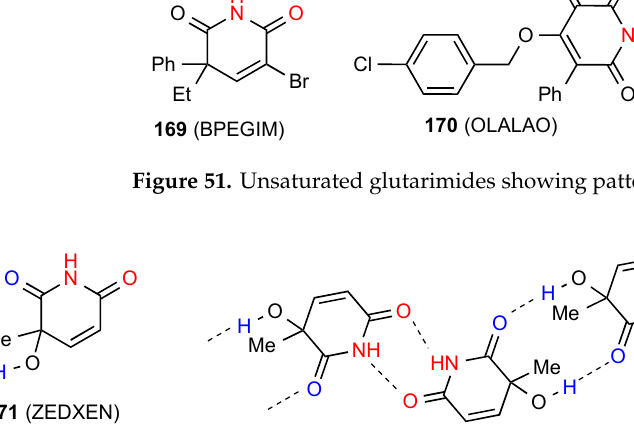
Figure 52. Structure adopted by compound 171.